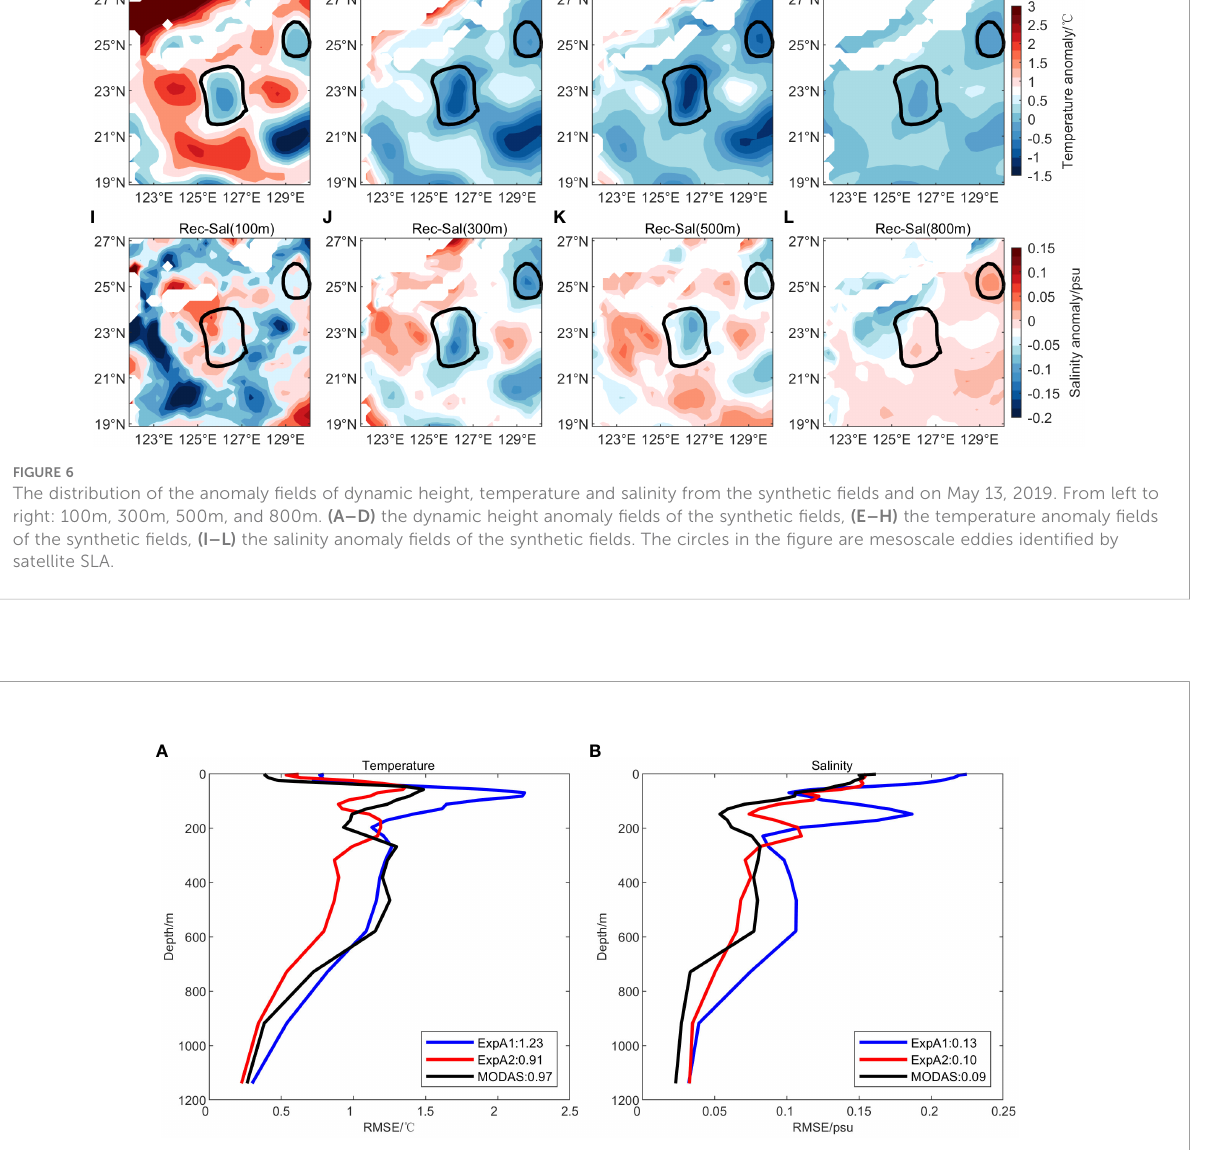
FIGURE 7 RMSEs of ROMS in nowcasting all the available EN4.2.1 T/S pro fi les. (A) temperature and (B) salinity (black line: MODAS data; red line: the experiment results of assimilating the synthetic T/S observations; blue line: the experiment results of assimilating sea surface observations). Numbers represent depth means of the